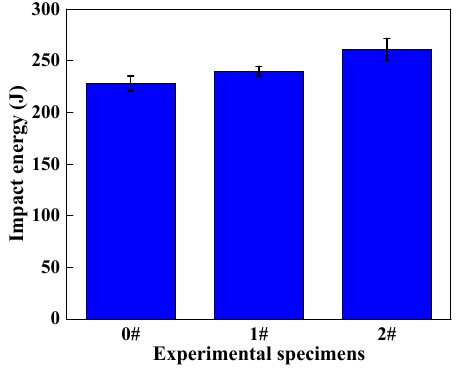
Figure 8. Impact energies of the 0#–2# experimental specimens.